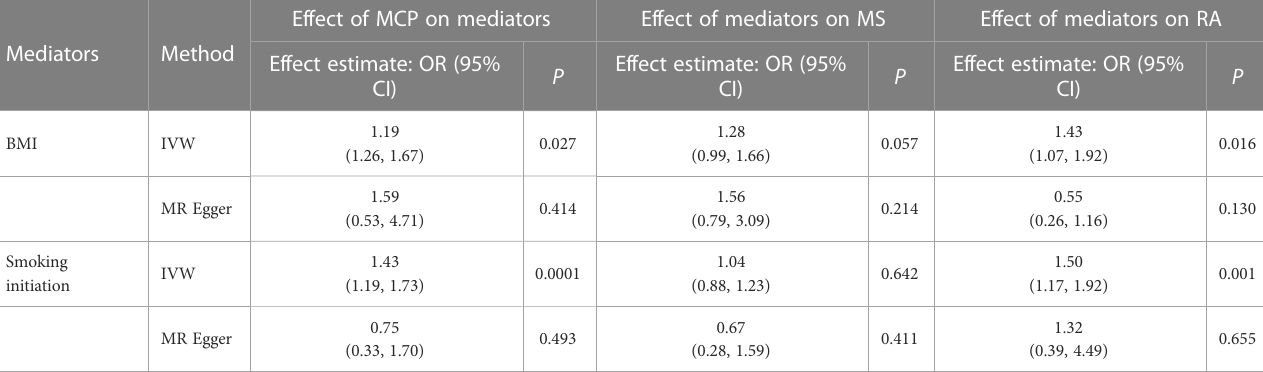
TABLE 3 Causal effect of multisite chronic pain on mediators and of mediators on MS/RA in two-step Mendelian randomization analyses.